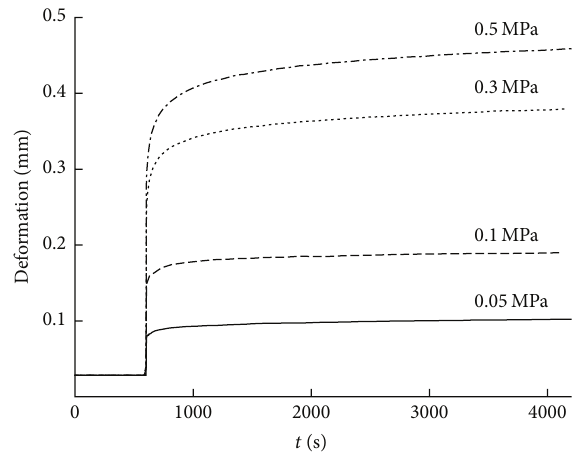
Figure 2: Creep curves of CA mortar under different load level.